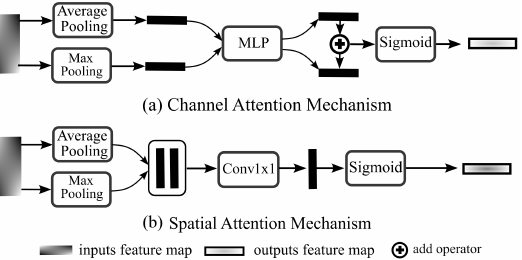
Figure 2. The overview of CAM and SAM. Whereas SAM focuses on spatial direction, CAM empha- sizes the significance of channel